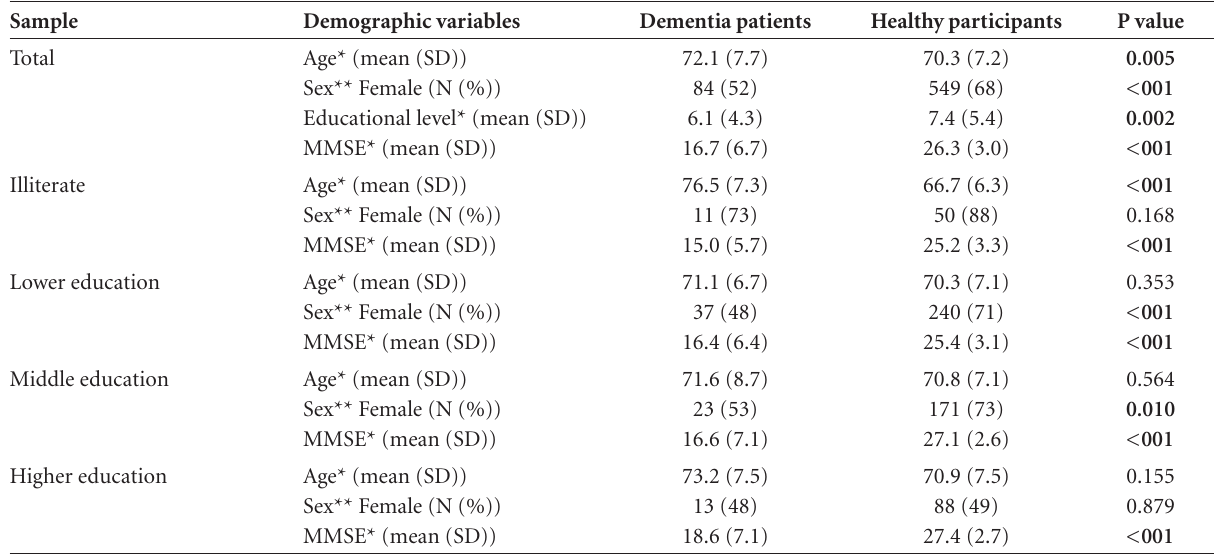
Table 1. Demographic data on dementia patients and healthy elderly participants in the total sample by educational level.